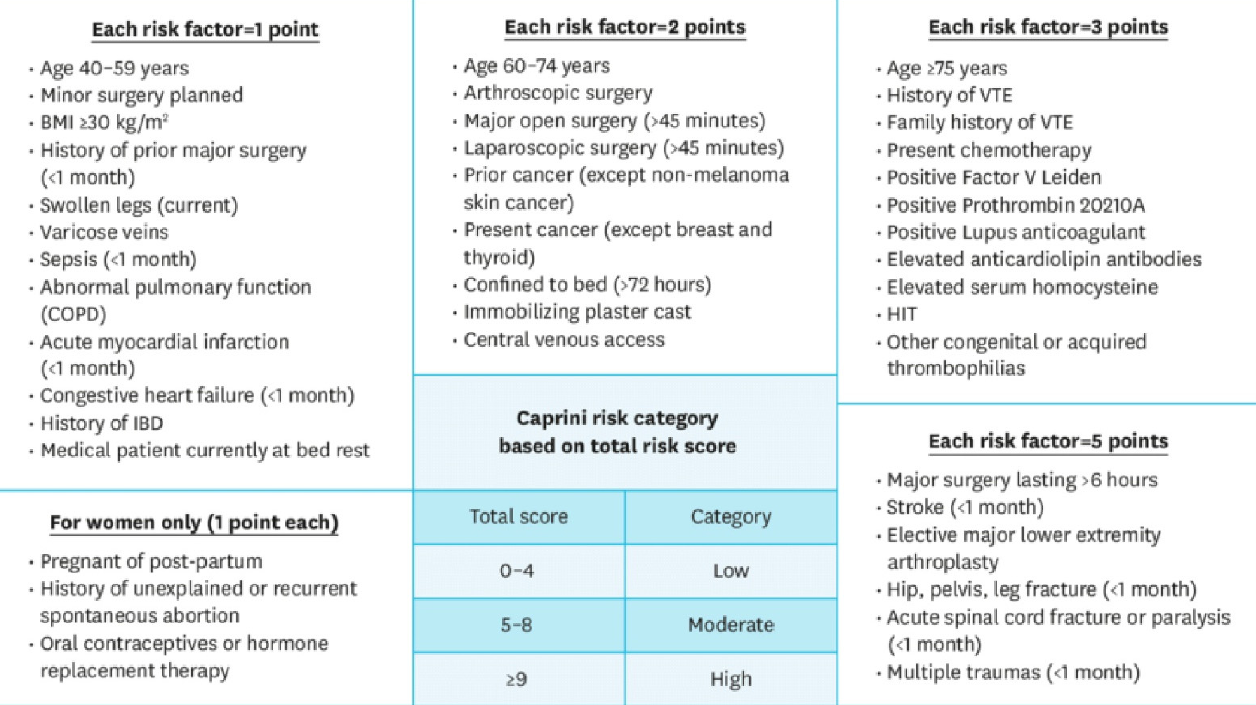
Figure 1. Caprini Risk Score (RCS). The Caprini Risk Score was developed to provide an adequate and individualized VTE prophylaxis risk assessment model. The score assigns points based on 20 risk factors taken from a patient’s past medical history as well as their current health, in which a higher score classifies a patient at a higher risk. Previous studies in other surgical specialties, such as otolaryngology, bariatrics, thoracic surgery, and plastic reconstructive surgery, have demonstrated the predictive efficacy of the Caprini Risk Score [32].